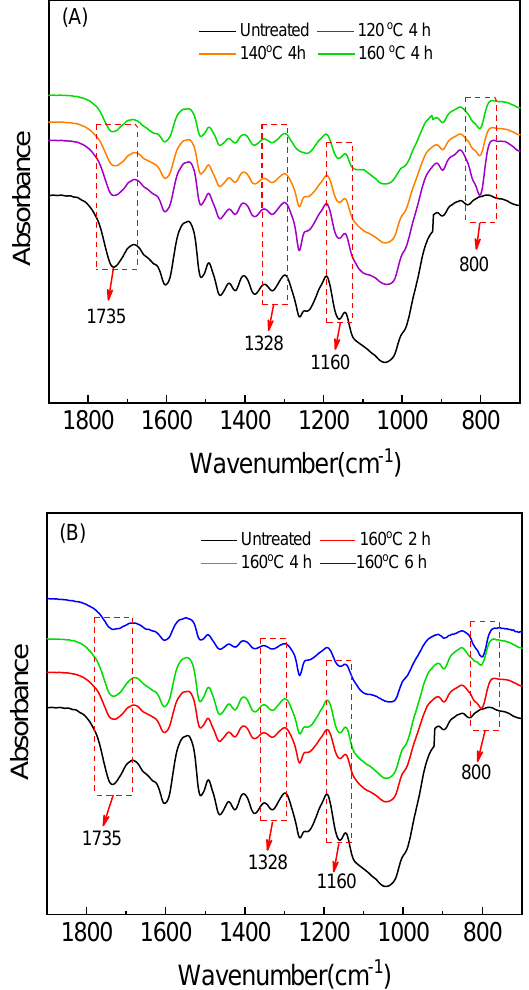
Figure 2. ( A ) FTIR spectra of the bamboo scrimber after hot oil treatment (temperature is variable); ( B ) FTIR spectra of the bamboo scrimber after hot oil treatment (time is variable).